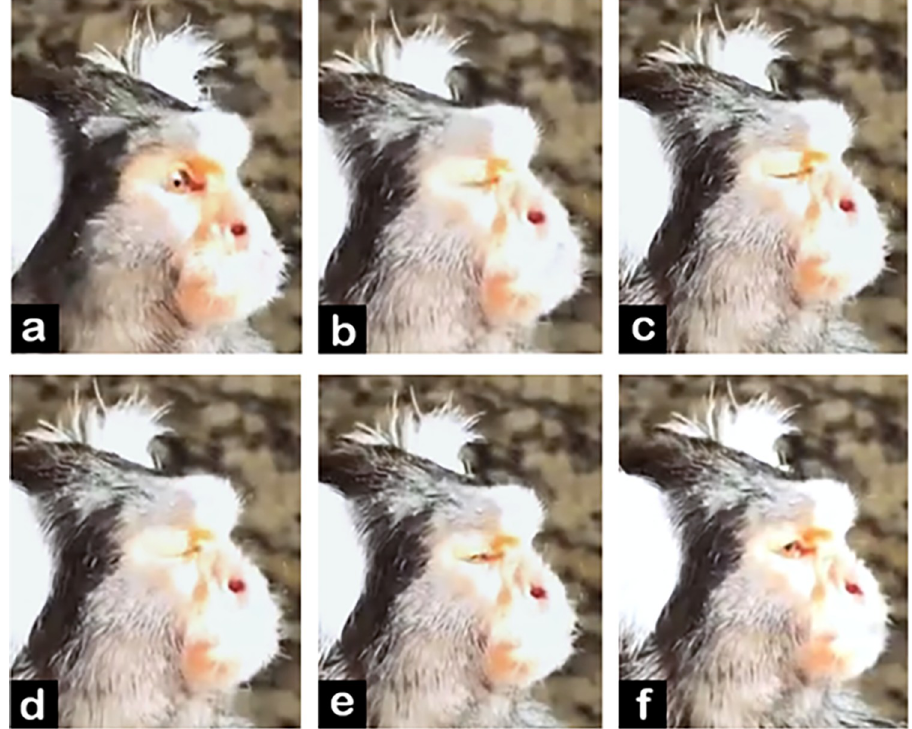
Fig 10. Examples of eyelid position at the apex of AU43/45 or AU47. a) eyelids do not cover eyeball, and thus AU43/ 45 and AU47 are not present. b), c) and d): eyelids cover eyeball completely at the apex of the eyelids movement, and thus AU43/45 is coded. e) and f): eyelids cover eyeball only partially at the apex, and thus AU47 is coded. Other AUs are present (e.g. AU41).